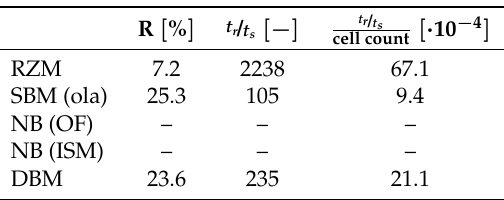
Table 17. Reflection coefficients, normalised run time and normalised run time per cell for the pSS absorption test